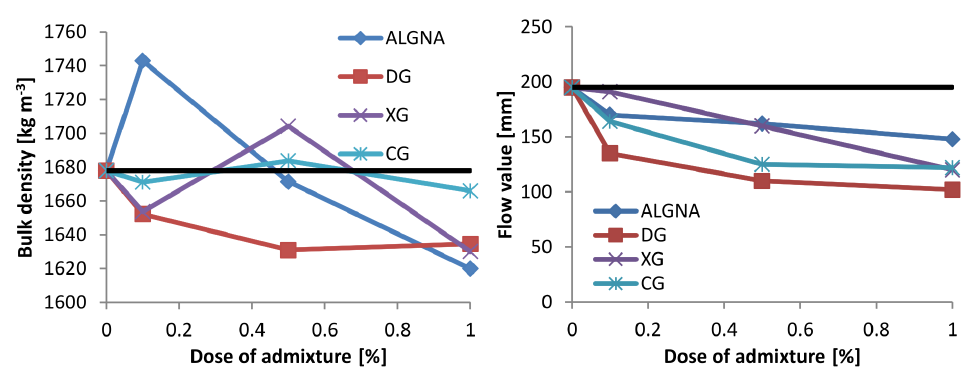
Figure 1. Flow values of fresh mortars and bulk density of 7 days old specimens.